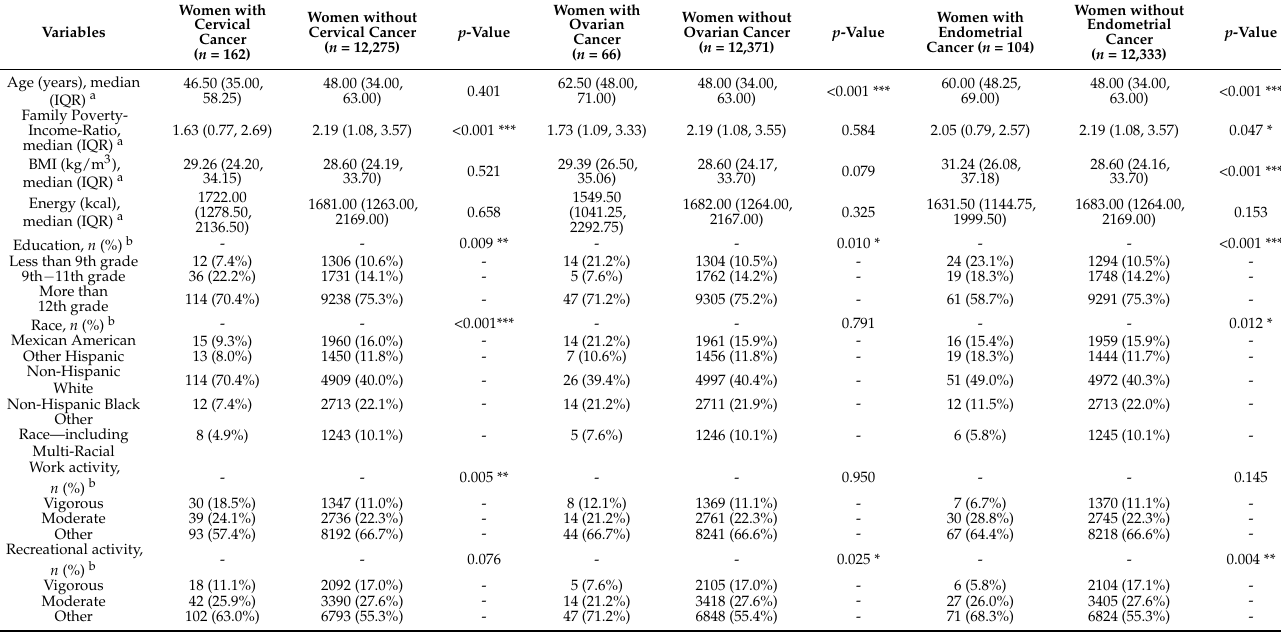
Figure 1. Flowchart of study participants. Table 1. Characteristics of participants with and without self-reported cervical cancer, ovarian cancer and endometrial cancer, separately.